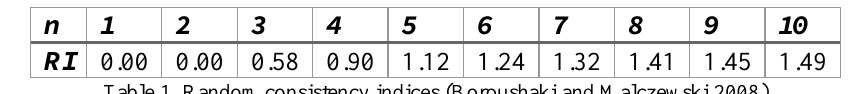
Table 1. Random consistency indices (Boroushaki and Malczewski